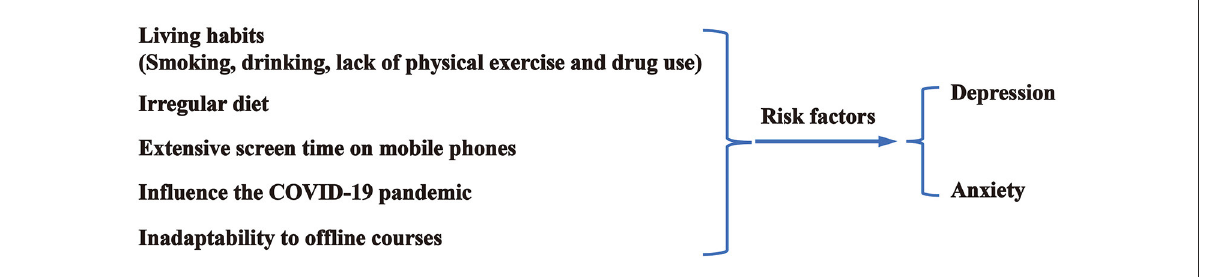
FIGURE1 Proposed research